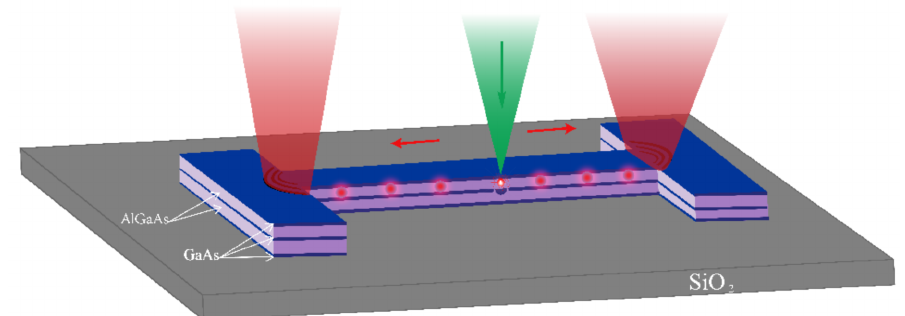
Figure 1. Design of the on-chip waveguide coupled single photon